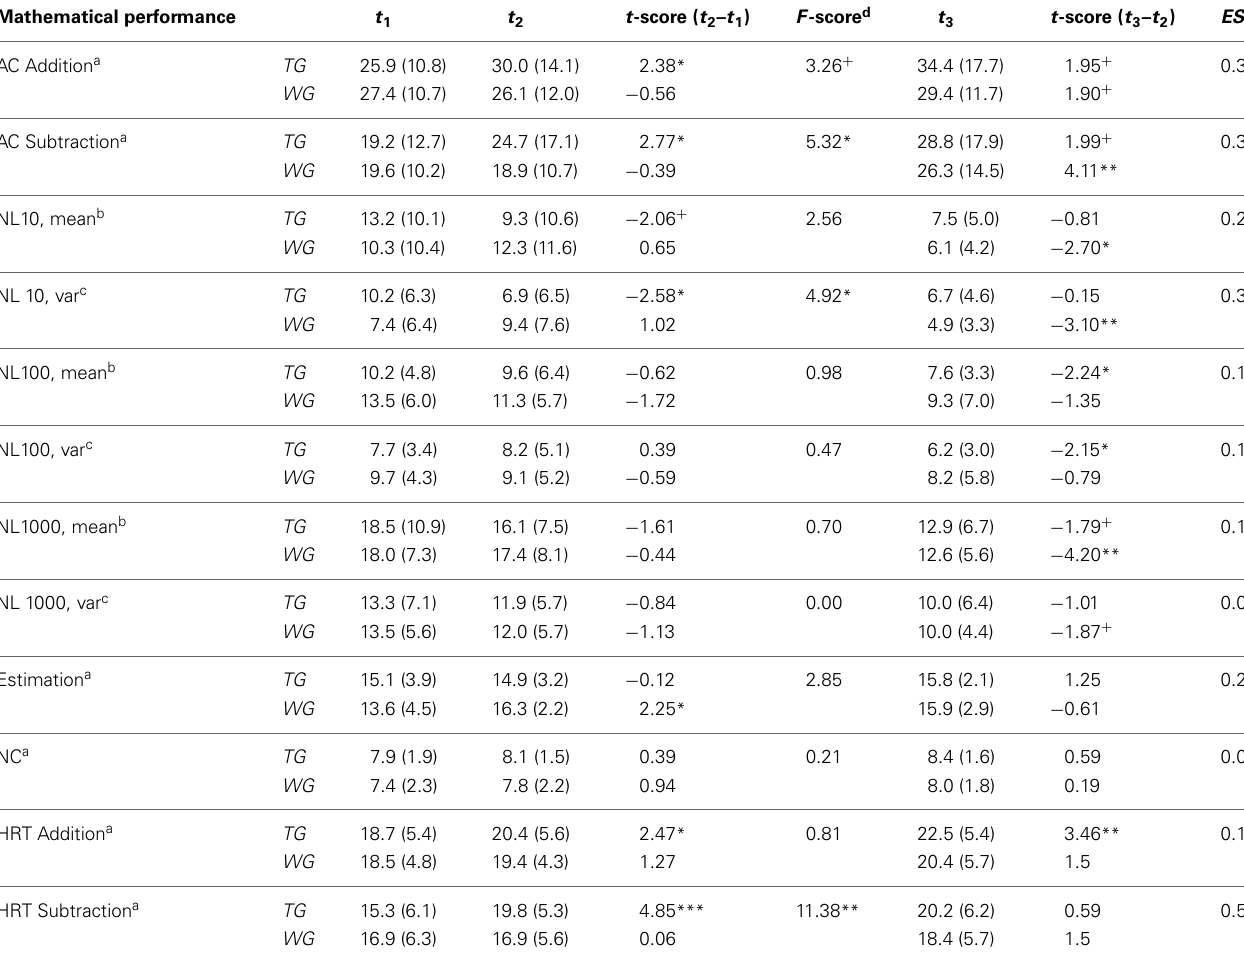
Table 3 | Training effects of training group TG ( n = 15) and waiting group WG ( n = 17) on mathematical performance [Means ( SD )]. Mathematical performance